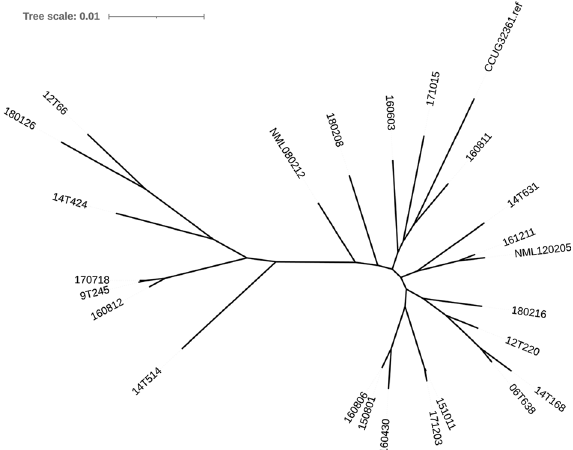
Figure 1. Phylogenomic comparison of all sequenced C. macginleyi strains. Results of a Parsnp analysis visualized with iTOL as an unrooted tree. The core genome covered 82% of the reference genome (CCUG32361); in total, 75,158 SNPs were found. The population could be divided into two clades: a major clade of 18 strains (clade I) and a minor clade of 7 strains (clade II). All strains were unique; the level of strain- specificity is illustrated by the length of the branches.